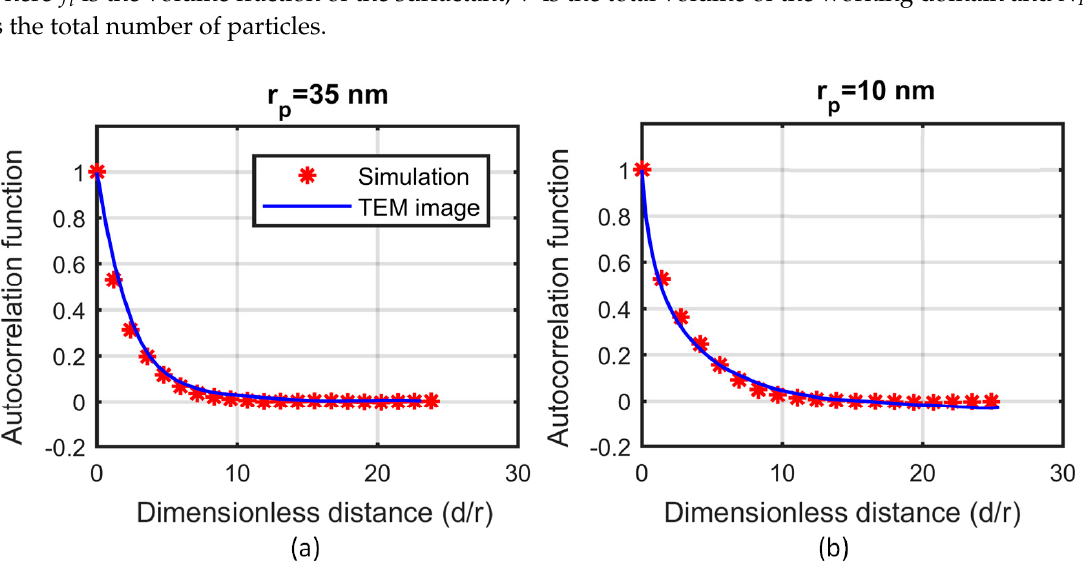
Figure 5. Autocorrelation function of the TEM image (continuous line), and the simulation results (red stars), for ( a ) particle radius 35 nm and ( b ) particle radius 10 nm.